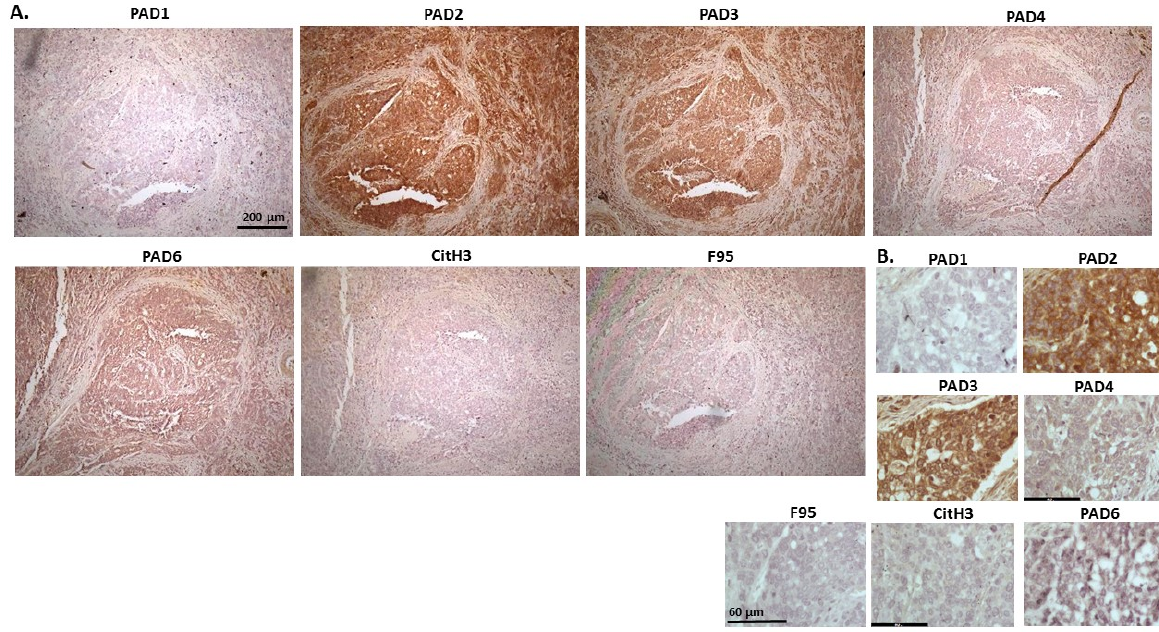
Figure 18. Horse (18-year-old mare), with carcinoma in liver, ovary and mesenteric lymph node. Carcinoma in liver is probable primary bile duct carcinoma but tumour metastasis to the liver cannot be ruled out. ( A ) Overview images for PAD1, 2, 3, 4, 6, CitH3, and F95 stainings of serial tissue sections; scale bar represents 200 μ m for all images; 10× objective. ( B ) Higher magnification shown for each staining from the images in ( A ); scale bar represents 60 μ m for all images; 40× objective.